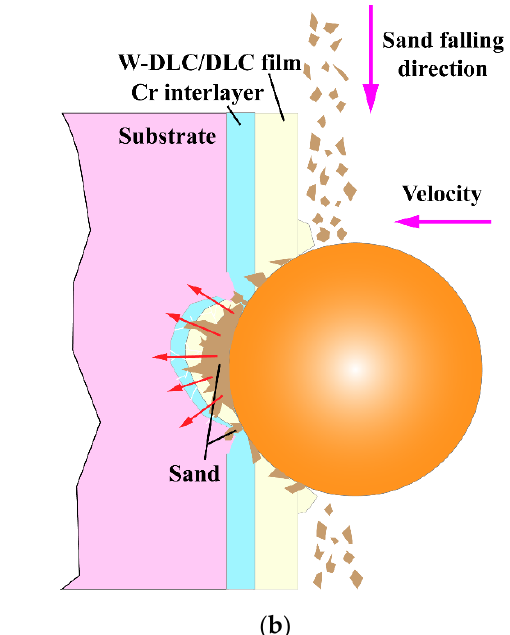
Figure 11. Wear scar topography and elemental distribution of Cr/W-DLC/DLC multilayer films at 500 ◦ C under the sand condition: ( a – c ) wear scar topography; ( d ) elemental distribution.